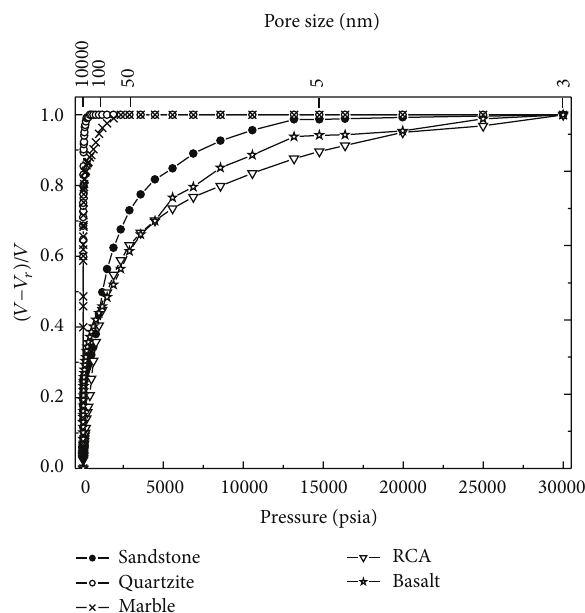
Figure 1: Curve of the pore distribution ratios of different coarse